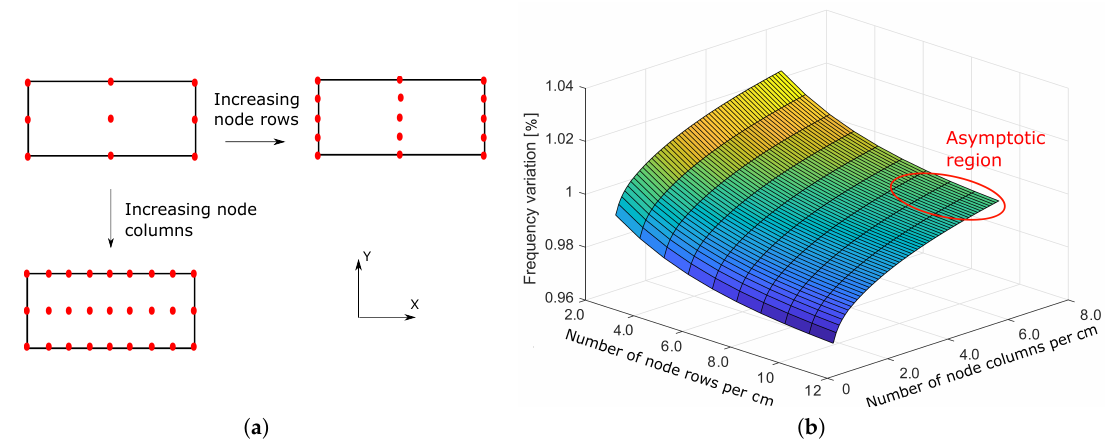
Figure 6. ( a ) Blade-strip contact patch discretization. ( b ) Frequency variation produced by variable number of master contact